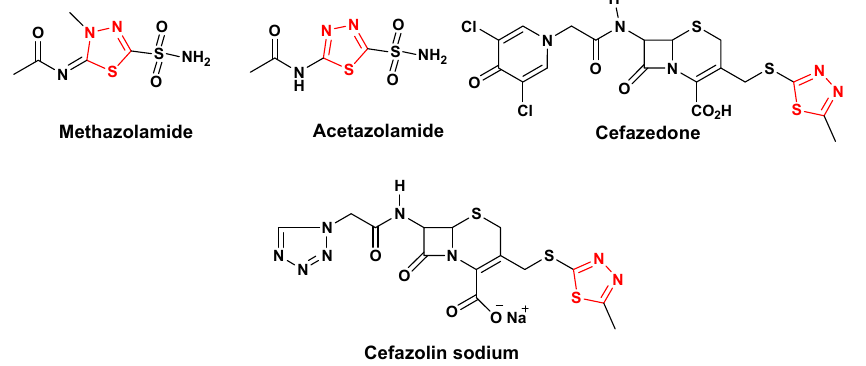
Figure 1. Some drugs on the market possessing a 1,3,4-thiadiazole